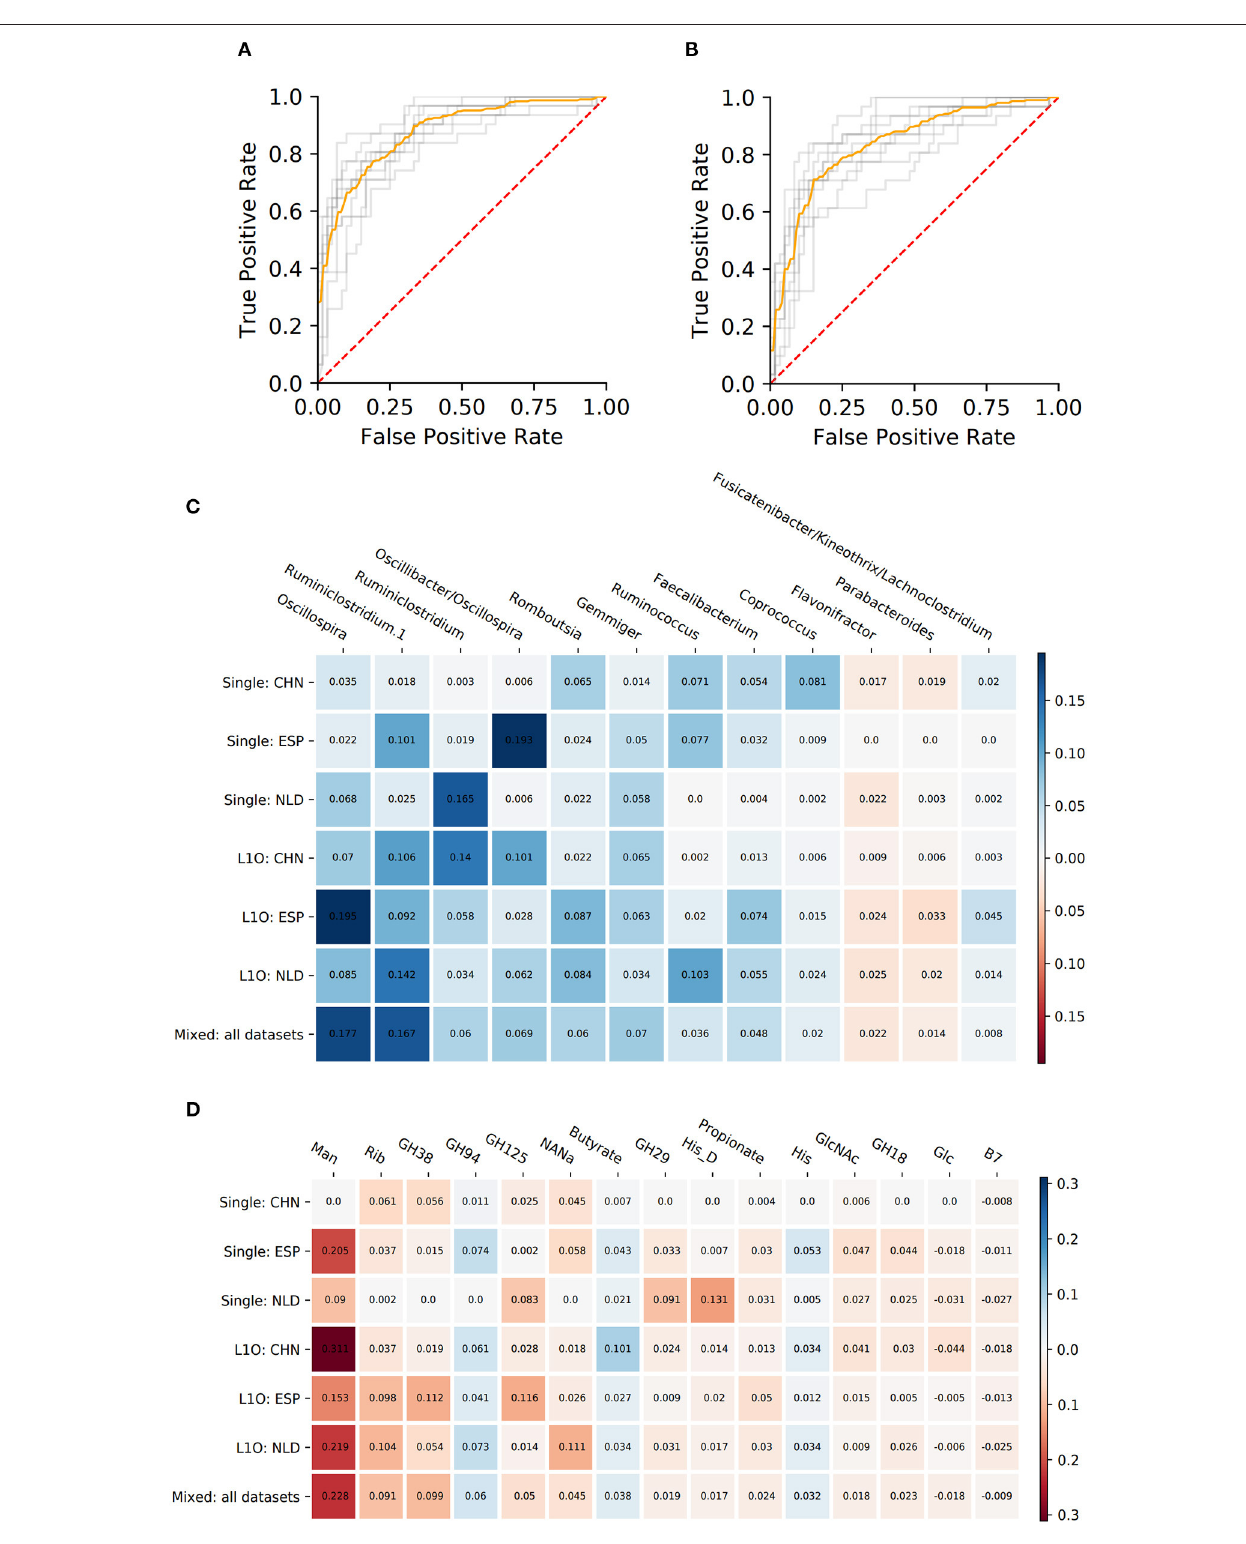
Frontiers in Molecular Biosciences |